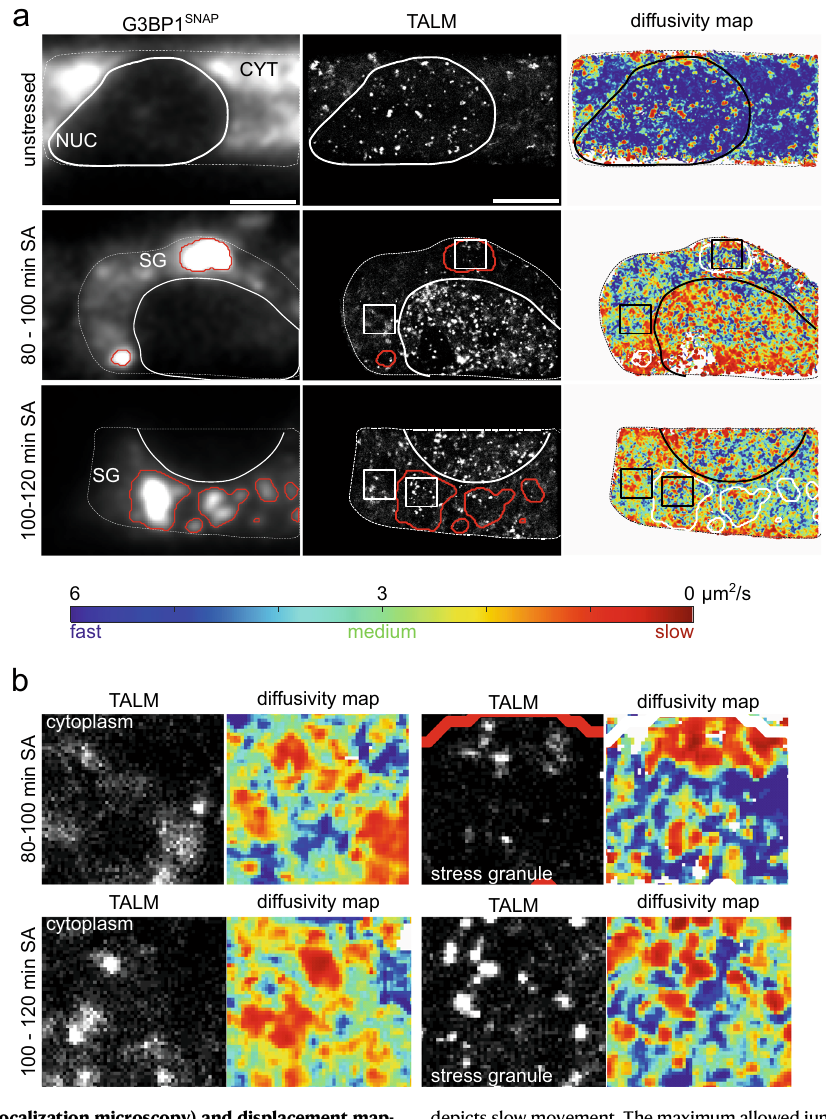
depicts slow movement. The maximum allowed jump distanceforthe analysis was 5pixels.Forbettervisualization,mobility>6 µ m 2 /sisdisplayedindarkblue. b Crops ofTALMandDMimagesofregionswithinthecytoplasmandstressgranules.Local binding hotspots (TALM, white spots) correlate with a reduced TDP-43 mobility (DM, red regions)inbothregions.Anoverviewofthe numberofanalyzedcellsper condition giving similar results is given in Supplementary Table